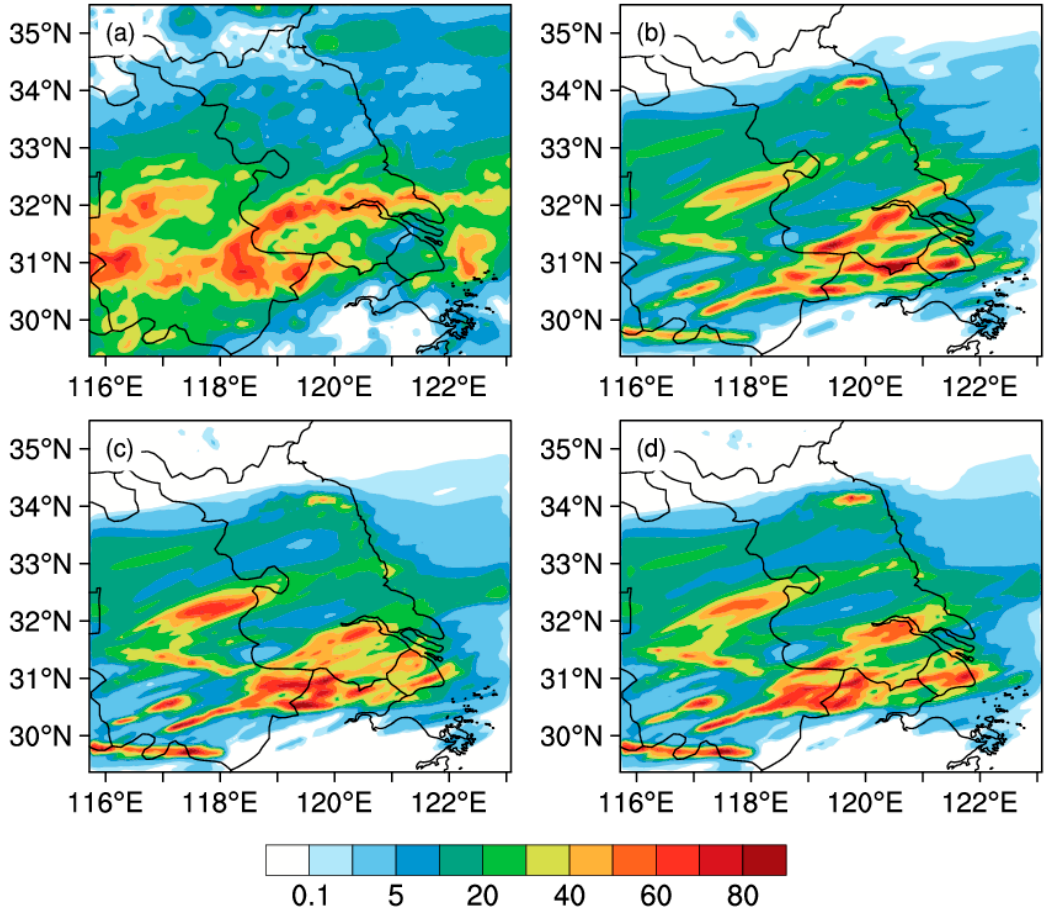
Figure 9. 12-h accumulated precipitation distribution for 0000 UTC to 1200 UTC on 12 July 2014 (unit: mm); ( a ) observation, ( b ) Down, ( c ) ET_3DR, and ( d ) ET_3DR_ESA.